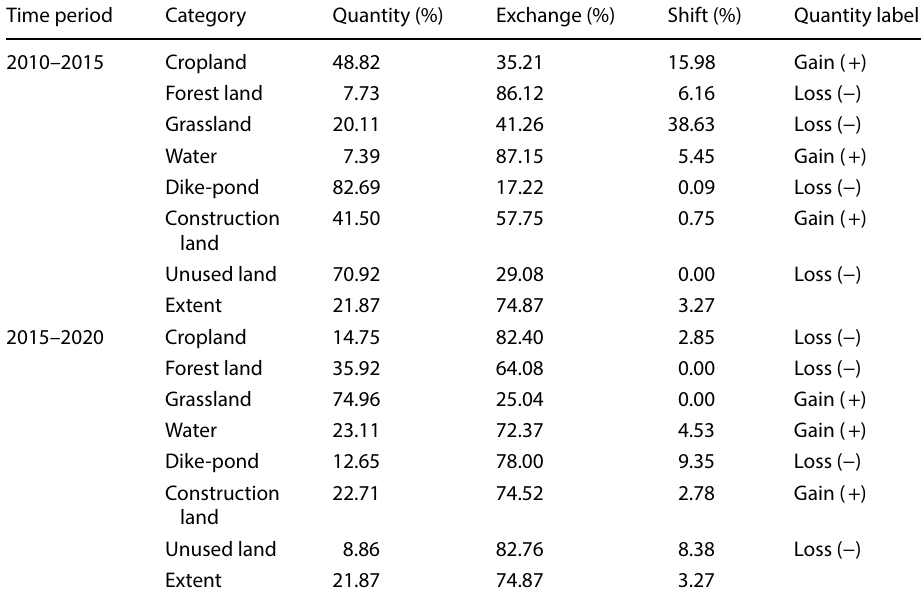
Table 2 Intensity of change across categories in two periods in